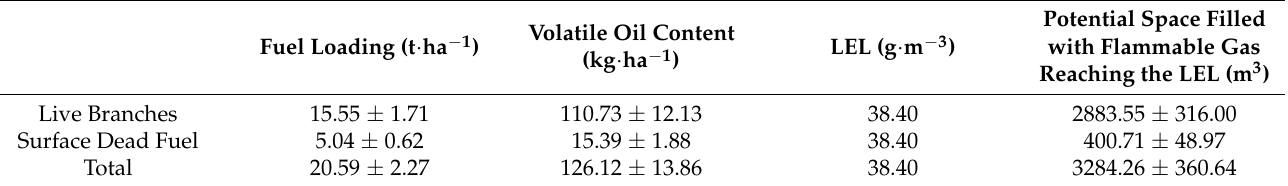
Table 5. Potential space filled with flammable gas reaching the LEL per hectare of P. yunnanensis forest when heated in a fire